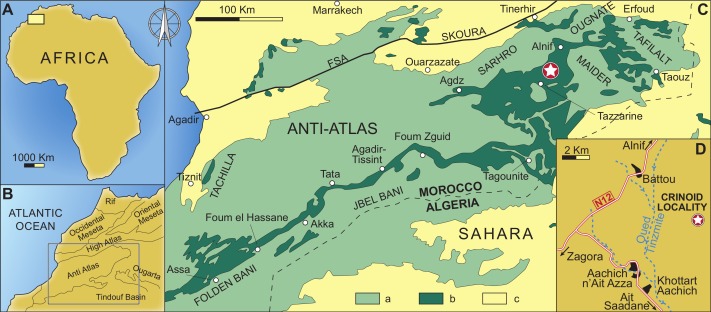
Geographical and geological setting of the eastern Anti-Atlas Mountains, Morocco, showing the type locality of the new species (indicated by a star) close to the village of Battou.After Rábano, Gutiérrez-Marco & García-Bellido (2014). (A) Map of Africa. (B) Detailed map of west Africa showing the position of the Anti-Atlas Mountains. (C) Simplified geological map of Morocco with the position of the studied locality; a: Precambrian and Palaeozoic rocks, b: Ordovician rocks, c: post-Palaeozoic cover. (D) Geographic map indicating the position of the studied locality.